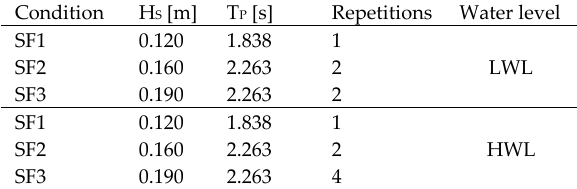
Fig. 5. (a) 3D model of the h-WEC (geometry B only), (b) physical model of the h-WEC integrated into a section of the breakwater, and (c) wave channel